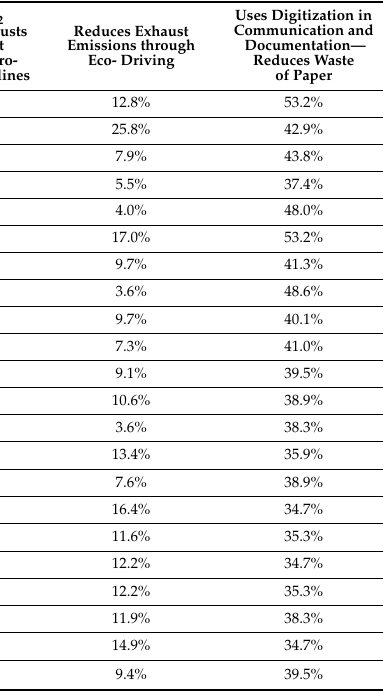
Table 6. Identification of solutions used by operators of last-mile logistics